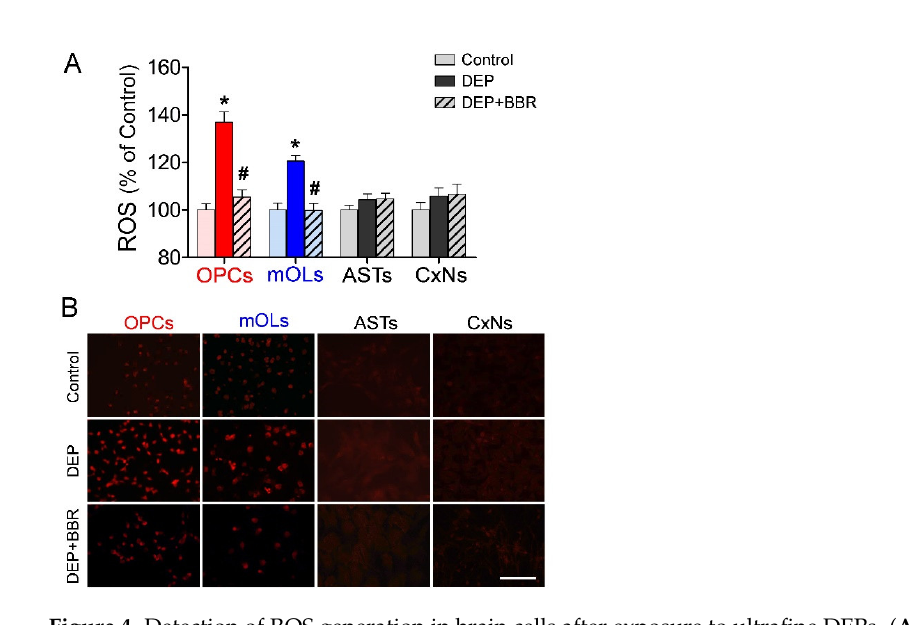
Figure 4. Detection of ROS generation in brain cells after exposure to ultrafine DEPs. ( A ) DCF assay. ROS generation in OPCs and mOLs after exposure to ultrafine DEP (200 μg/mL) is significantly increased compared with that in each control group. However, BBR treatment significantly inhibits ROS generation in OPCs and mOLs exposed to ultrafine DEPs. ( B ) DHE staining. ROS generation after exposure to ultrafine DEPs is markedly increased in OPCs and mOLs, whereas ROS generation is not observed in astrocytes and cortical neurons in each group. ASTs = astrocytes, CxNs = cortical neurons. * p < 0.05 for DEP group vs. control, # p < 0.05 for DEP + BBR group vs. DEP group. Scale bar = 200 μm.